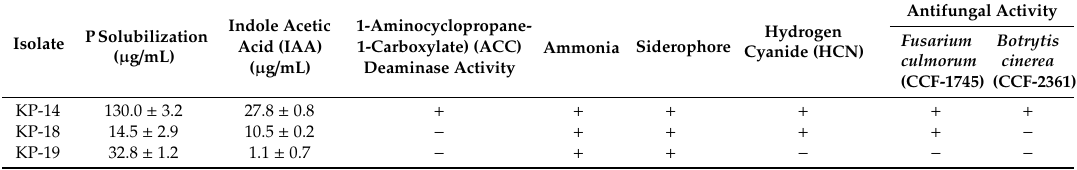
Isolate PSolubilization ( µ g /